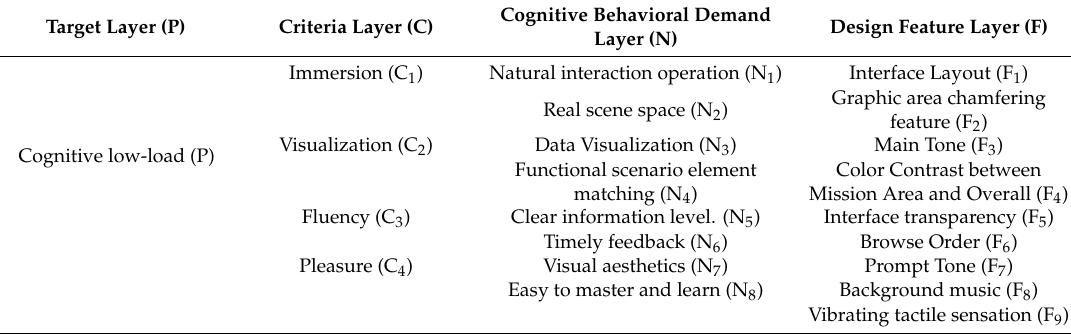
Table 6. Hierarchical list of the user’s cognition of low-load